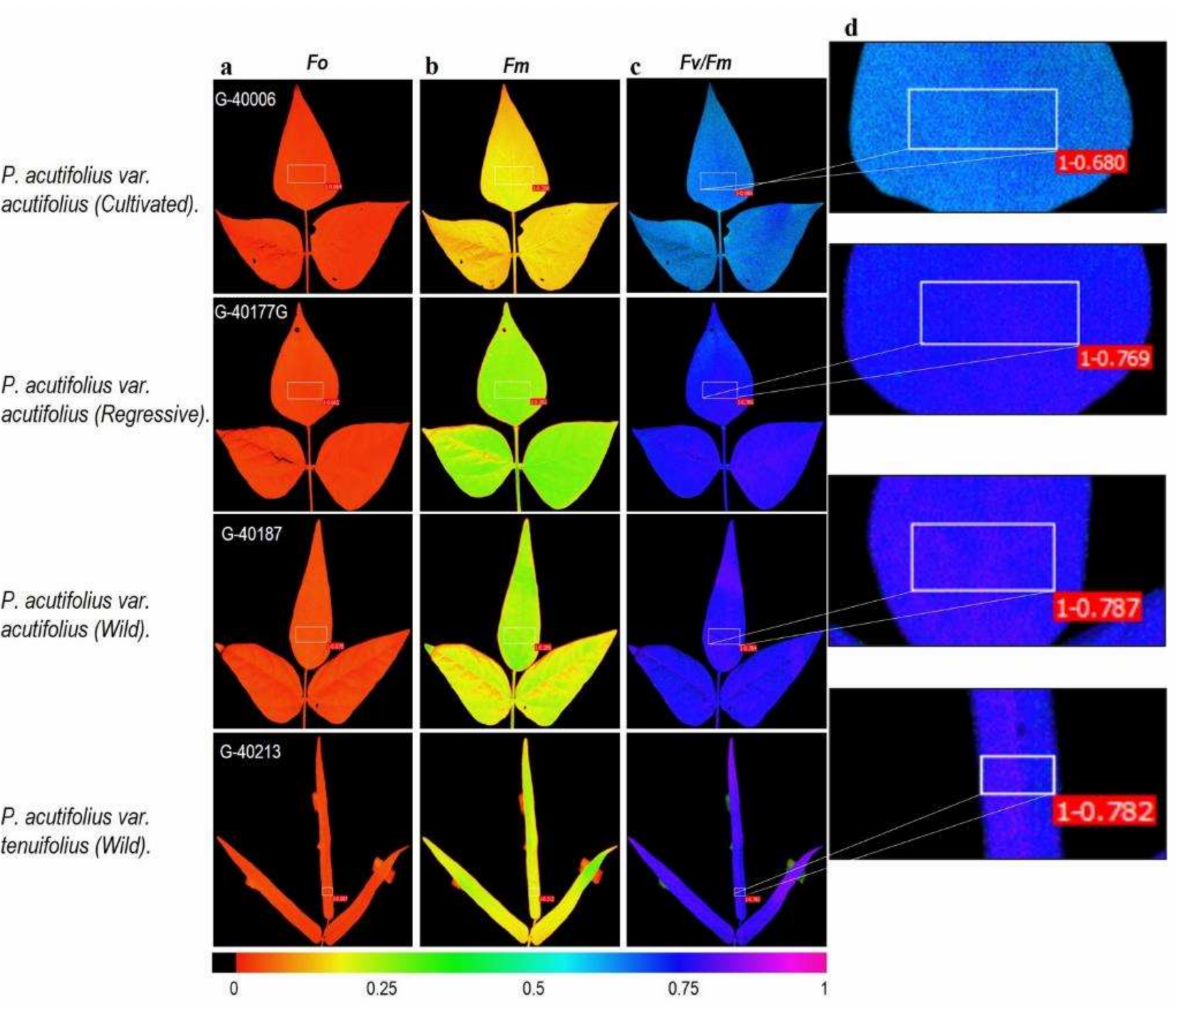
Figure 4. Images of chlorophyll a fluorescence parameters taken in fully developed leaves at the onset of physiological maturity the tepary bean genetic resource: ( a ) Initial fluorescence (F 0 ), ( b ) maximum fluorescence (F m ), ( c , d ) maximum quantum efficiency of PSII (F v /F m ). ( d ) An example of the area of interest (AOI) tested on each leaf to obtain the fluorescence variables is shown. Gradient in color change from violet to red means higher to lower value for each